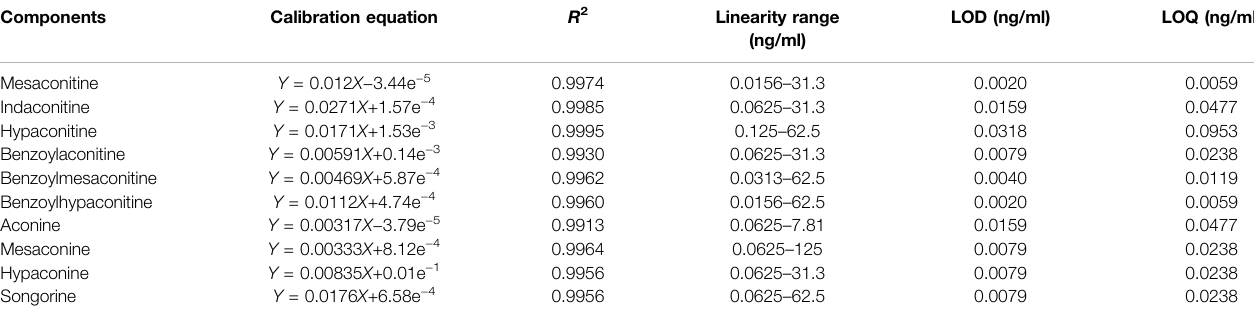
TABLE 2 | Linearity, LOD, and LOQ of target components. Components Calibration equation